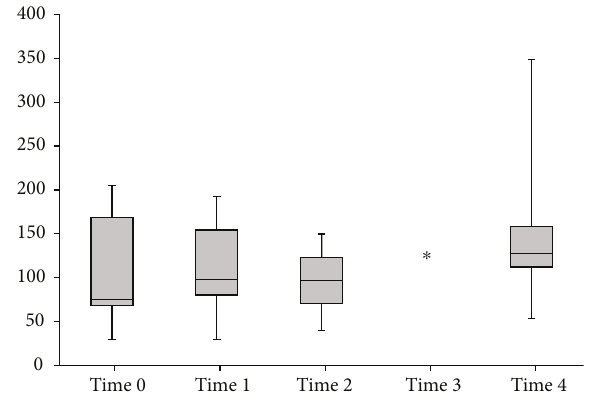
Figure 2: Middle hepatic vein blood fl ow index measured by transesophageal echocardiography. Box and whisker diagram of middle hepatic vein blood fl ow index expressed in ml/min/m 2 . Whisker extremities are maximum and minimum, boxes are interquartile ranges between the 75th and 25th percentiles, and the segment inside the box is the median of the sample. P value < 0.001 results from a Friedman ’ s two-way analysis of variance by rank. The ∗ indicates a signi fi cantly di ff erent value compared to baseline with the Wilcoxon signed-rank test. Time 0: after induction of general anaesthesia, before starting epidural analgesia. Time 1: 30min after beginning epidural analgesia. Time 2: end of CRS, before abdominal fi lling. Time 3: end of HIPEC, before abdominal emptying. Time 4: end of procedure, after abdominal emptying and removal of abdominal drainage.